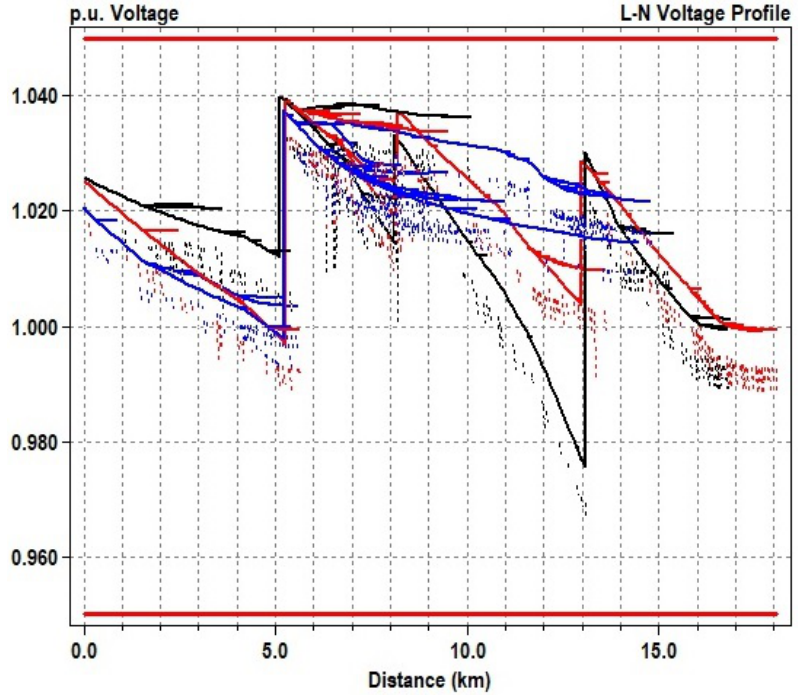
Figure 4. Voltage profile of the test feeder without any DER and with balanced loads. Phases A, B, and C are denoted in black, red, and blue, respectively. The dotted lines mark the voltage magnitude on the secondary side of the transformers